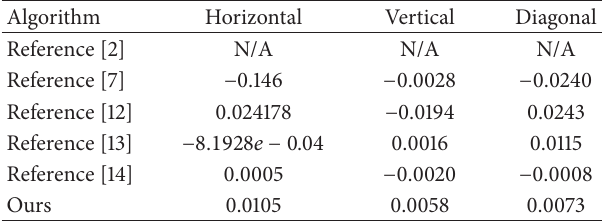
Table 4: Comparison with other encryption